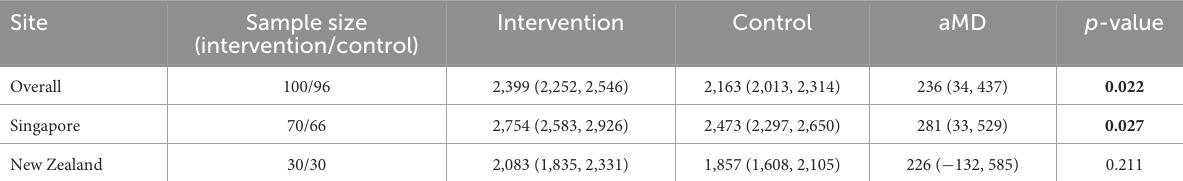
TABLE 6 Time-weighted area-under-the-curve for zinc concentrations ( µ g/mL/day) in human milk samples collected in the NiPPeR study between birth and 3 months of age.